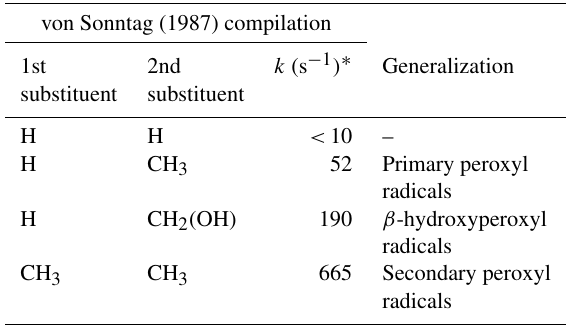
∗ HO · 2 elimination rate